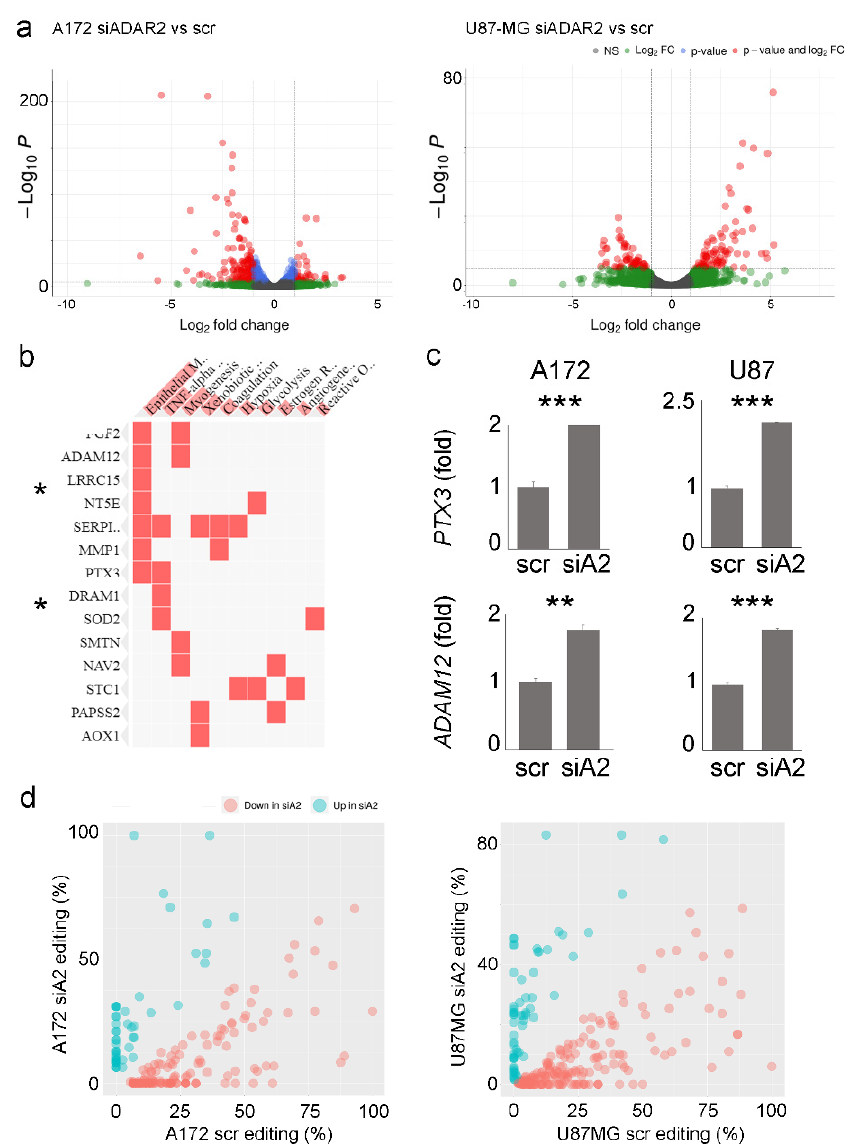
Figure 4. Gene expression profile and RNA editing pattern changes upon ADAR2 silencing. ( a ) Vol- cano plots showing the effect of ADAR2 silencing on the A172 and U87-MG cell lines transcriptome in terms of significance levels and fold changes in gene expression as calculated by DESeq2. The cut-off for log2FC is >|2| and the cut-off for the p.adj value is 1 × 10 − 6 . ( b ) Gene enrichment analysis showing the pathways in which common genes are significantly upregulated in A172 siADAR2 and U87MG siADAR2, * p < 0.05. ( c ) qRT-PCR showing the expression levels of PTX3 and ADAM12 transcripts in control and siADAR2 A172 and U87-MG cells. Mean ± standard deviation t -test, ** p ≤ 0.01, *** ≤ 0.001. ( d ) Scatter plots reporting the editing levels (%) for sites significantly ( t -test, p- value < 0.05) modulated between scramble (scr) versus silenced ADAR2 (siA2) cell lines. The under-edited sites in siADAR2 are shown in light red, while the upregulated sites are shown in cyan.